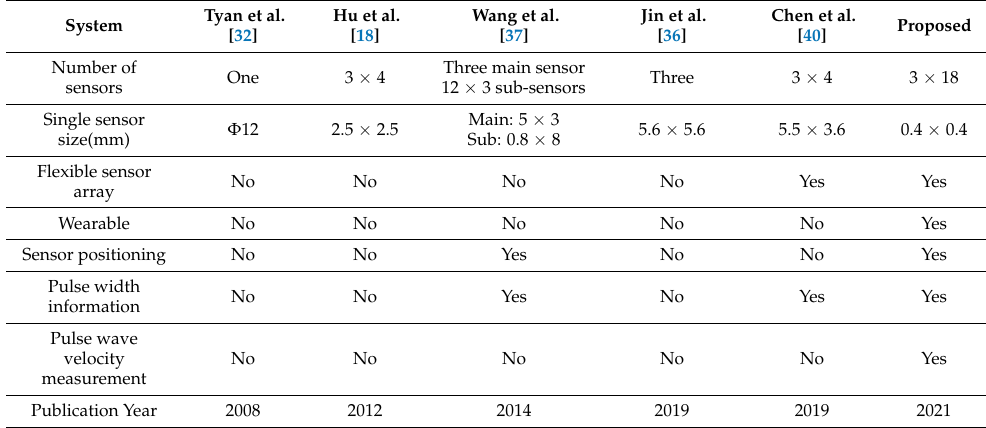
Table 3. Comparison of the proposed sensor array to other pulse measurement